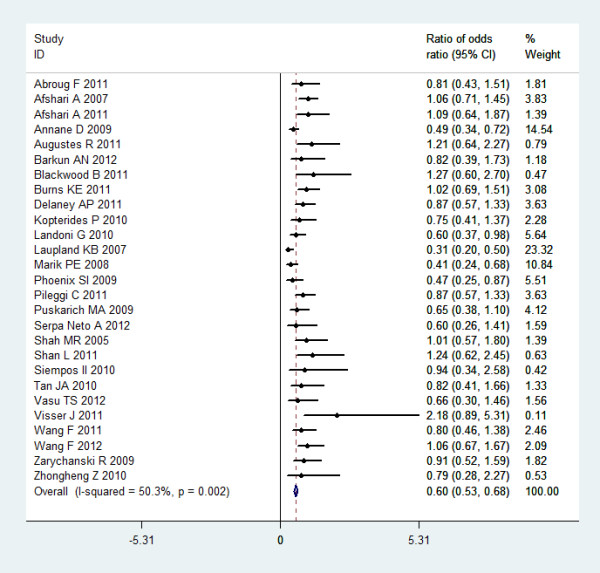
Forest plot showing the ratio of odds ratio between small and large trials.